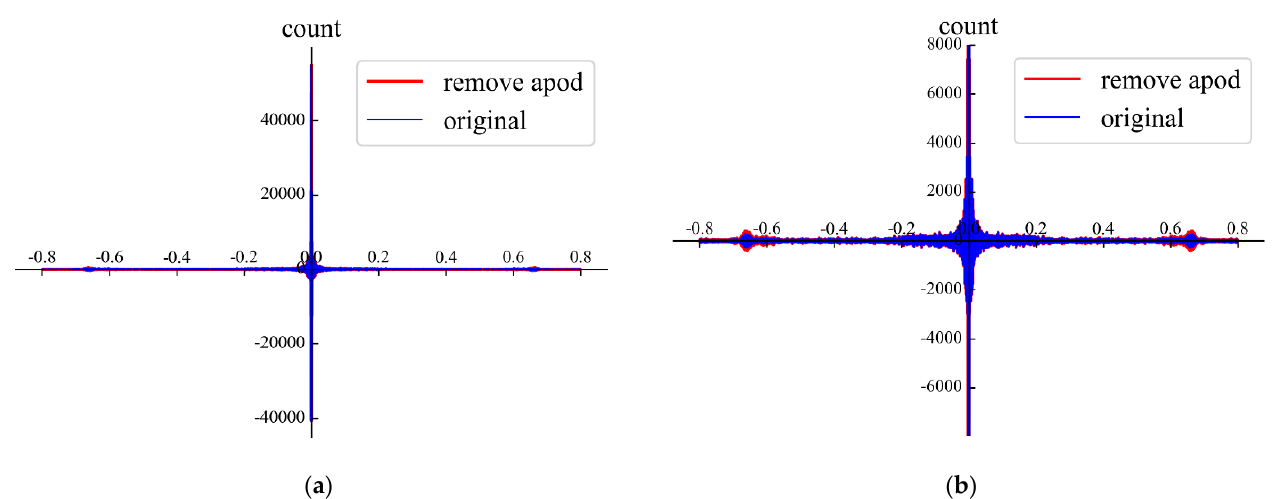
Figure 2. IASI interferogram before and after apodization: ( a ) the blue line represents the original interferogram and the red line represents the interferogram after removing apodization. The abscissa is the optical path difference (OPD). ( b ) A partial enlarged image.